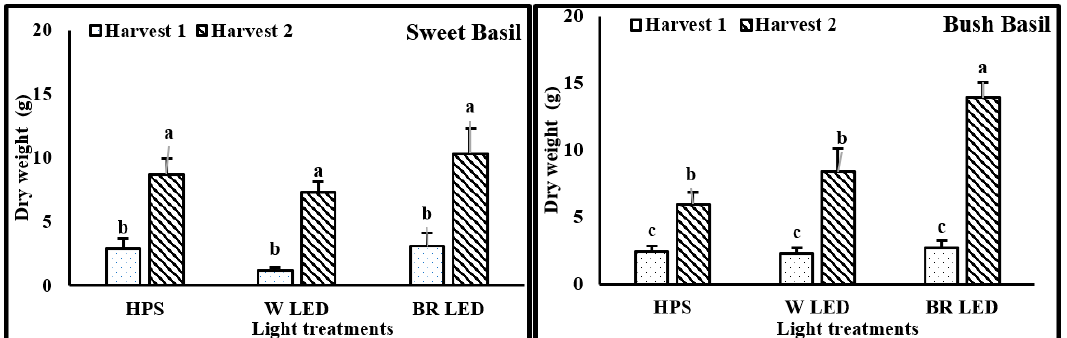
Figure 8. The effect of light treatments and harvest stage on plant dry weight DW of sweet basil (LSD = 1.5 for the harvest stage) and bush basil (LSD = 1.6 for the lighting treatment, LSD = 1.3 for the harvest stage and LSD = 2.3 for the interaction between the lighting treatments and harvest stage). Different letters denote significant differences between treatments ( p < 0.001).